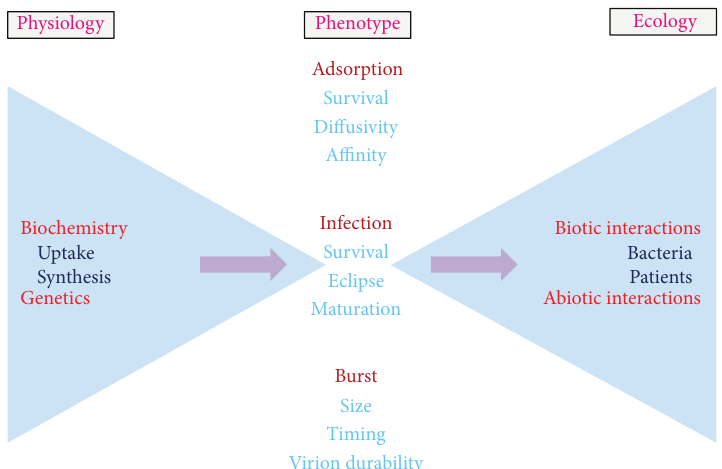
Figure 5: Molecular aspects of biology (left) give rise to organismal characteristics (middle) which in turn can give rise to ecological consequences (right). Ecological consequences include impact on environments as well as environment impact back onto organisms (not shown). Within phage therapy as a pharmacological process, these ecological consequences—with a patient’s body serving as environment— can be viewed as being equivalent to considerations of pharmacodynamics (drug impact on body) and pharmacokinetics (body impact on drug), respectively. Physiology in turn is a description of how an organism’s molecular aspects as well interactions with environments combine to give rise to organism functioning. Here physiological aspects are indicated, in the middle of the figure, particularly in terms of phage organismal properties. Phage physiology, within a phage therapy context, thus can be viewed as a highly complex elaboration on how chemical form, that is, of phages, gives rise to ecological properties (in terms principally of bacterial eradication), just as a pharmaceutical’s chemistry gives rise to its pharmacological characteristics. Despite the complexity of a phage’s chemical form as well as the process of translation of that form into so-called pharmacologically emergent properties, such properties as side effects can be less likely than the case with less-complex, small-molecule drugs. This often low phage propensity towards toxicity presumably is a consequence of phages consisting primarily of DNA (or RNA) and proteins that have been molded by evolution to be highly specific in their impact towards modification of bacterial metabolism and structure rather than that of eukaryotic organisms such as ourselves [66]. Note that this figure is modified from one found in Abedon